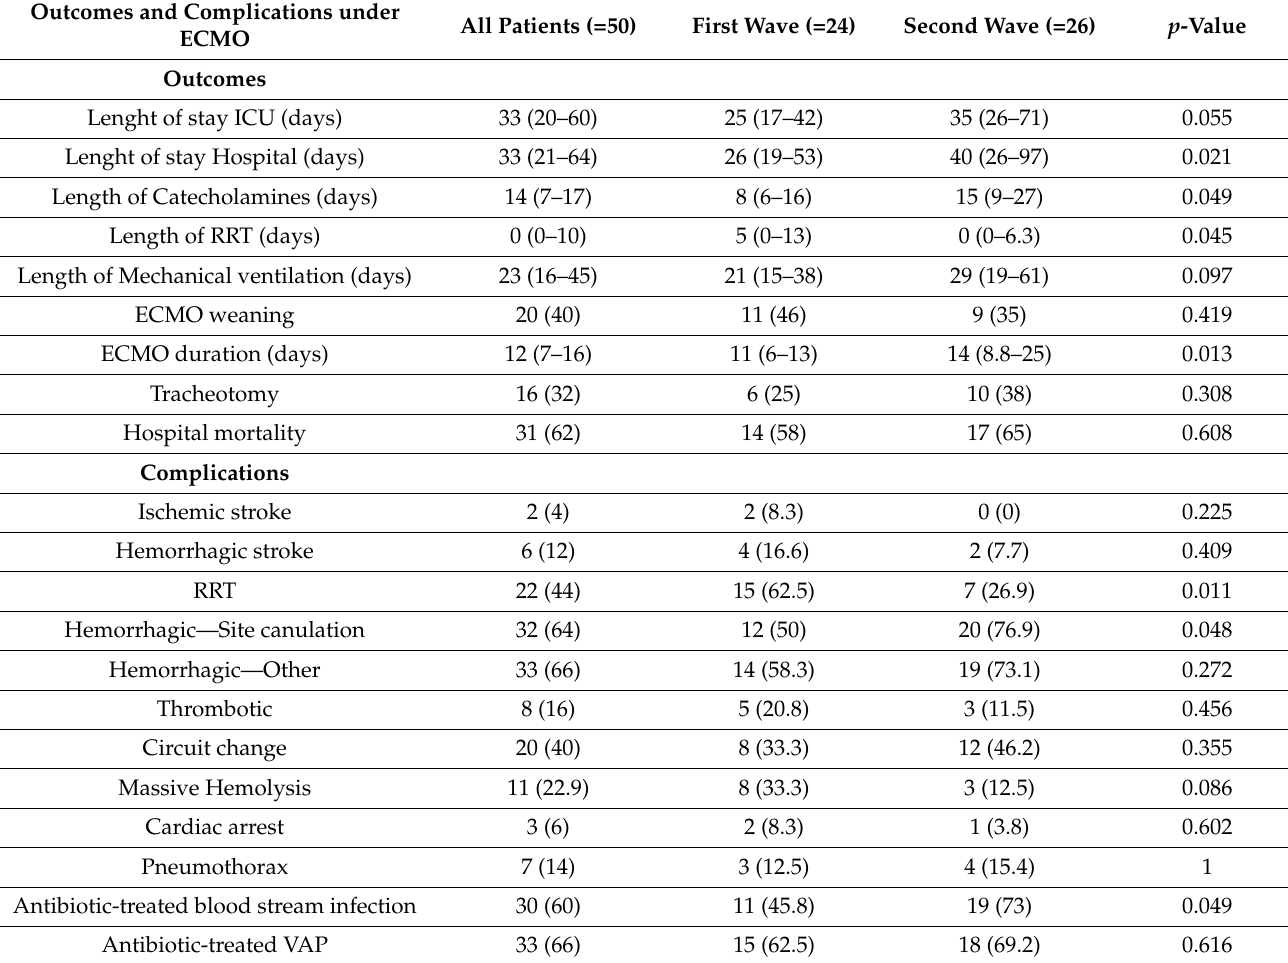
Table 4. Outcomes and complications under ECMO in First and Second Wave